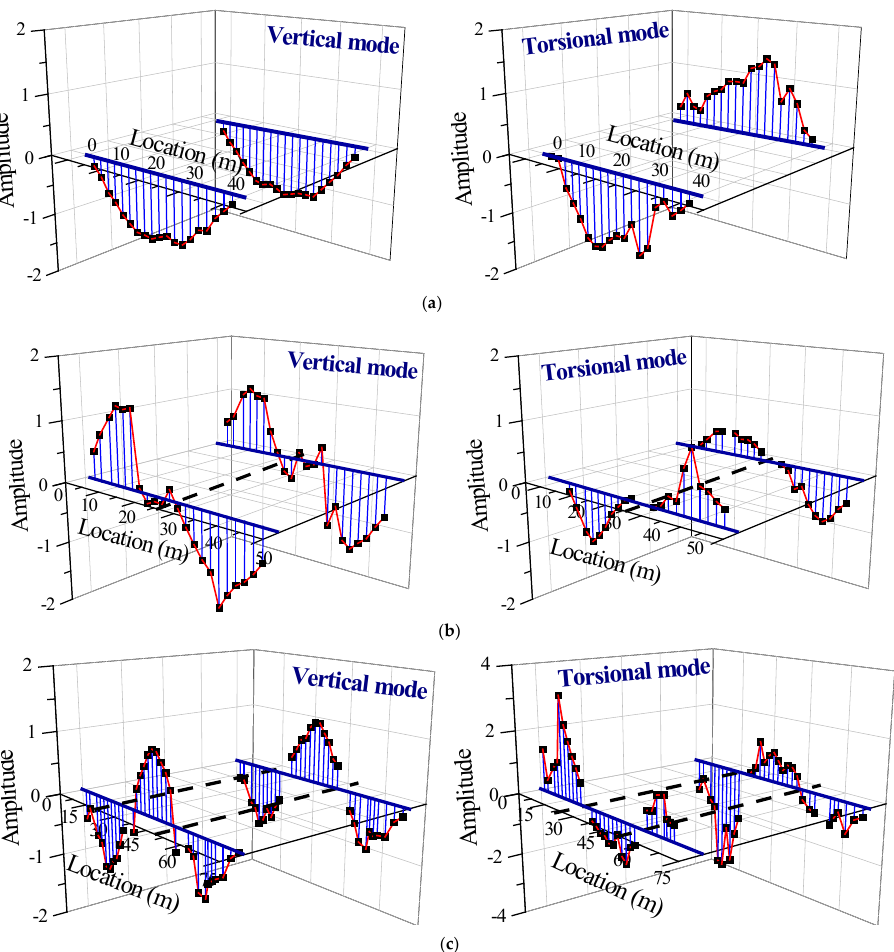
Figure 5. The mode shape estimated by applying proper orthogonal decomposition at the target bridges: ( a ) Imgi 2nd Bridge; ( b ) Maeaji Bridge; ( c ) Hwalchun Bridge.